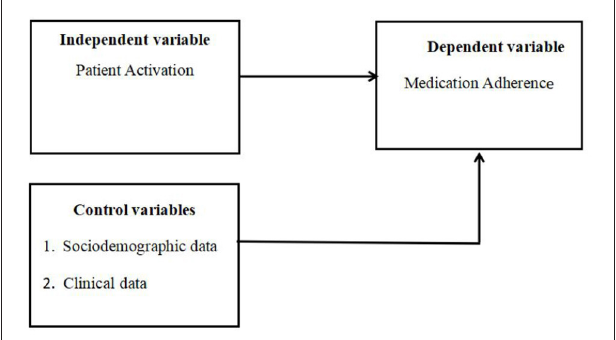
FIGURE 1 | The theoretical framework of this